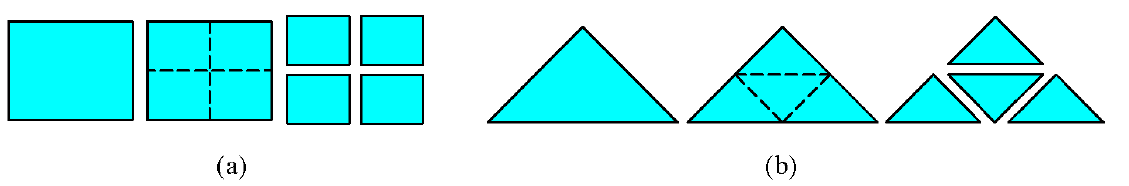
Figure 2. Interface segmentation: ( a ) quadrilateral; ( b ) triangular.